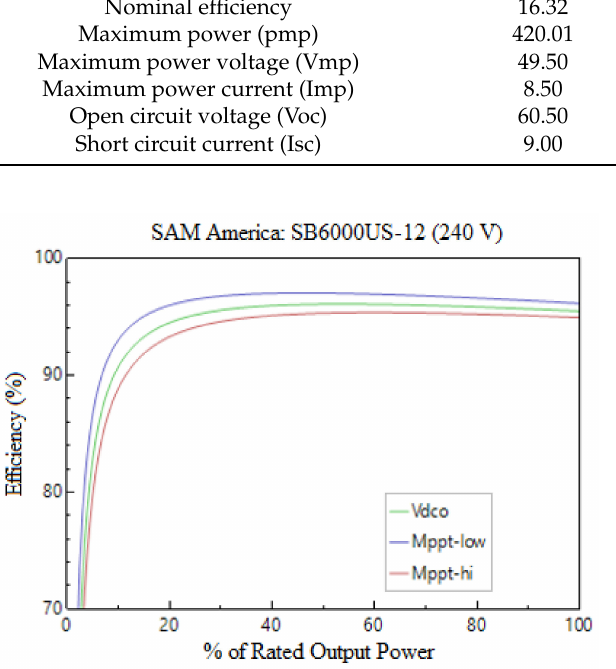
Figure 9. Inverter efficiency curve. Courtesy of NREL